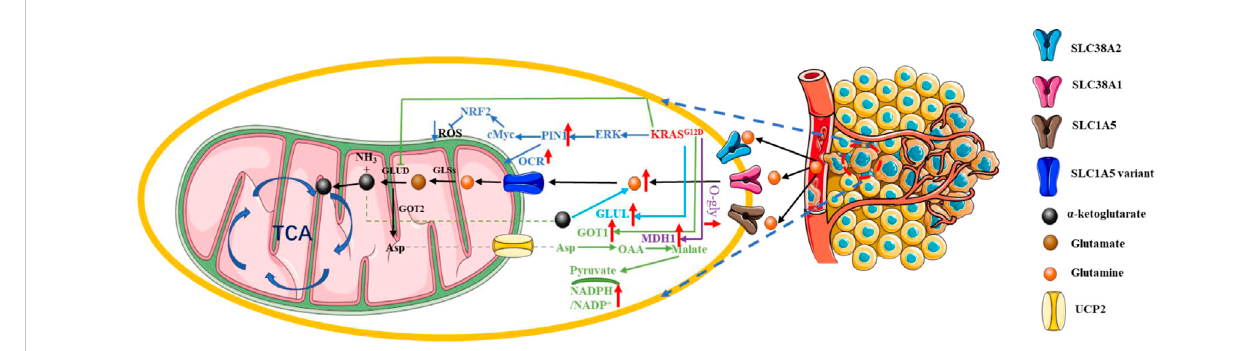
FIGURE 5 KRAS mutationinPDACglutaminemetabolicreprogramming. KRAS mutation-containingpancreaticcancercellshavegreatdemandforglutamine; this is also termed as “ glutamine addition ” . Red arrow: The expression of related gene is upregulated. Blue arrow: The expression of related gene is